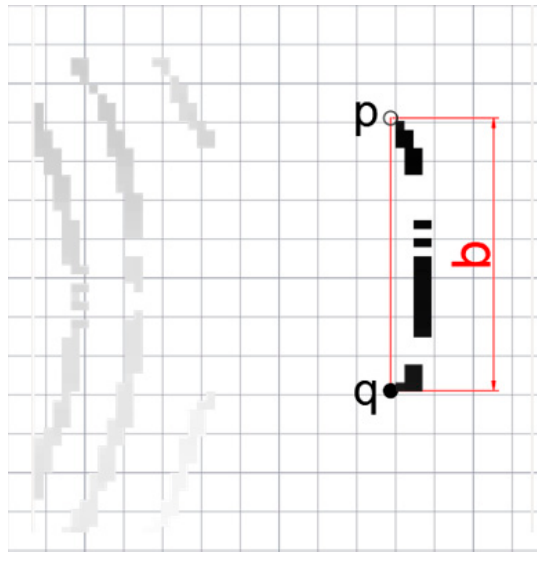
Figure 10. Estimating the length of negative obstacles.